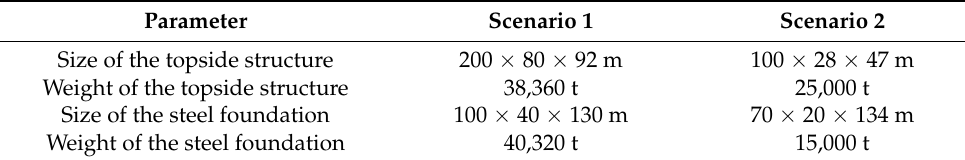
Table 10. The main parameters of the platforms according to Scenario 1 and Scenario 2.